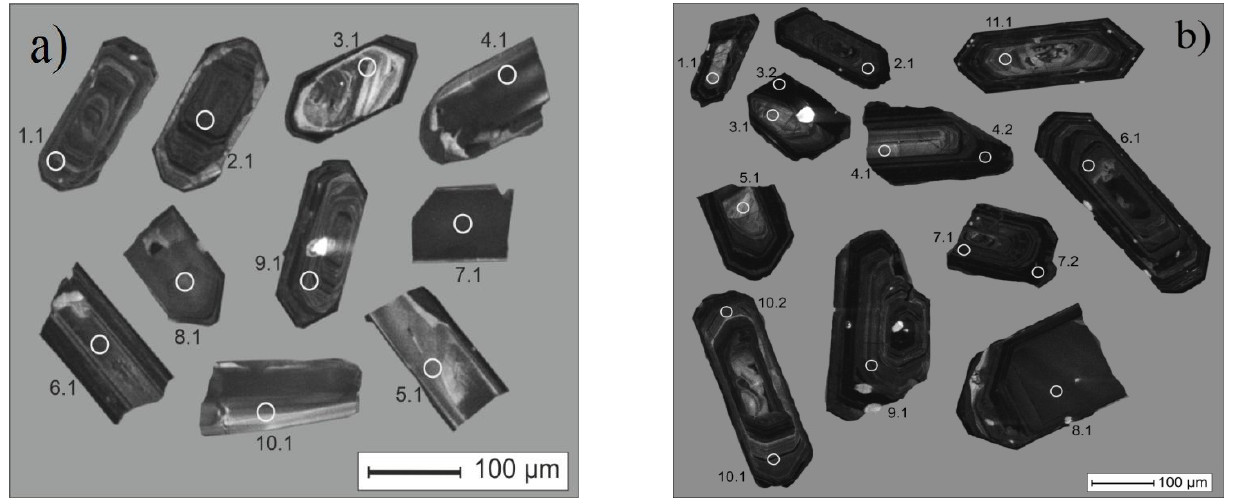
Figure 4. Typical CL images of zircons from the leucogranite (sample 108-B) ( a ) and from the biotite granites (sample DV-27/04) ( b ) of the Voznesensky complex. Circles show the SIMS SHRIMP analytical spots with their numbers corresponding to those in Table 1.